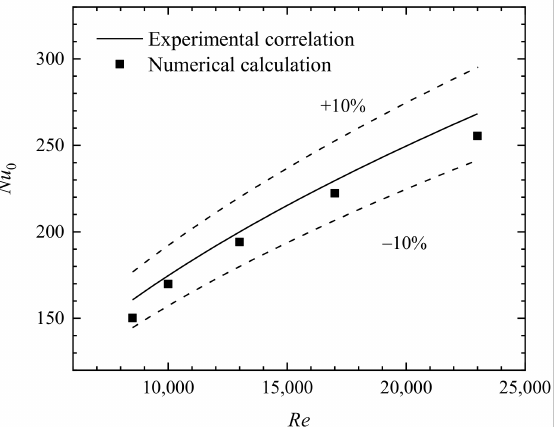
Figure 2. Comparison of Nu 0 determined by the numerical calculation and the